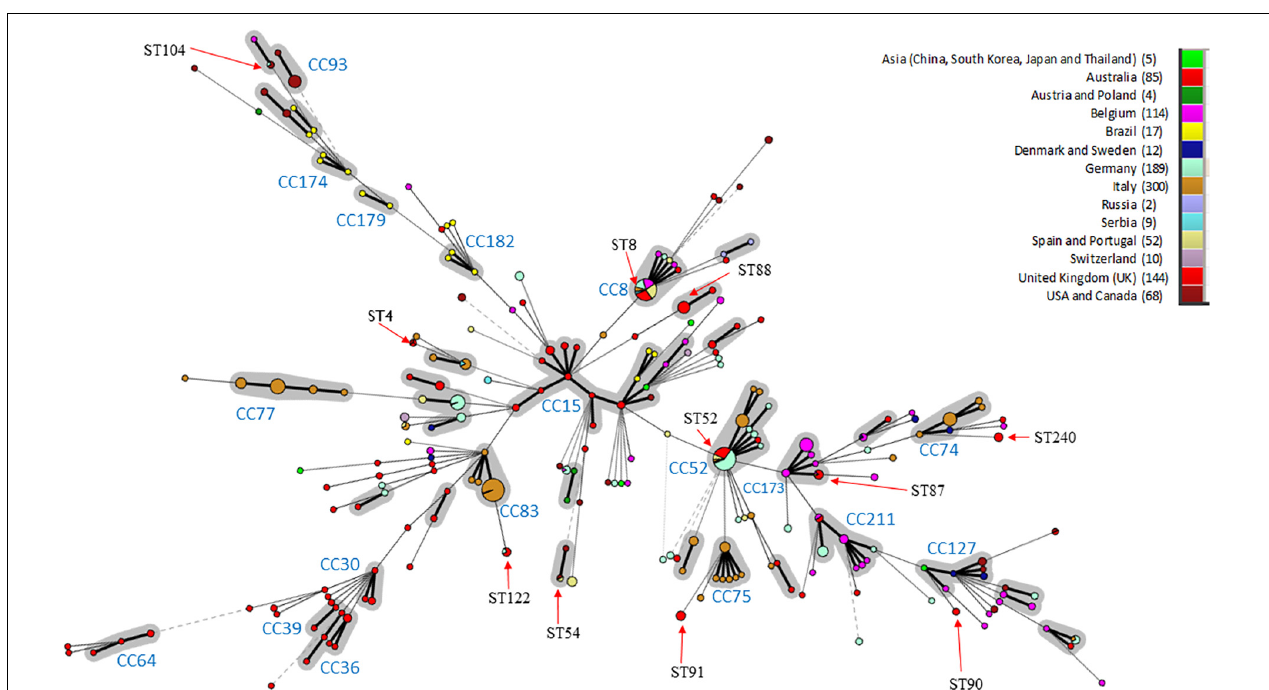
FIGURE 1 | Minimum-spanning Tree of B. hyodysenteriae sequence types. STs have been colored according to the country where isolates originate and the number of isolates from each country is indicated in brackets. CCs are shown in gray and CC with > 3 different STs or those previously identified by Joerling et al. have been labeled (Joerling et al., 2018). The size of the circle corresponds to the number of isolates of that ST within the collection. STs are labeled if possessing more than two UK isolates or the ST is shared between three continents. Arrows indicate where the ST is located in the tree. Note ST for the UK includes 29 additional isolated UK STs from